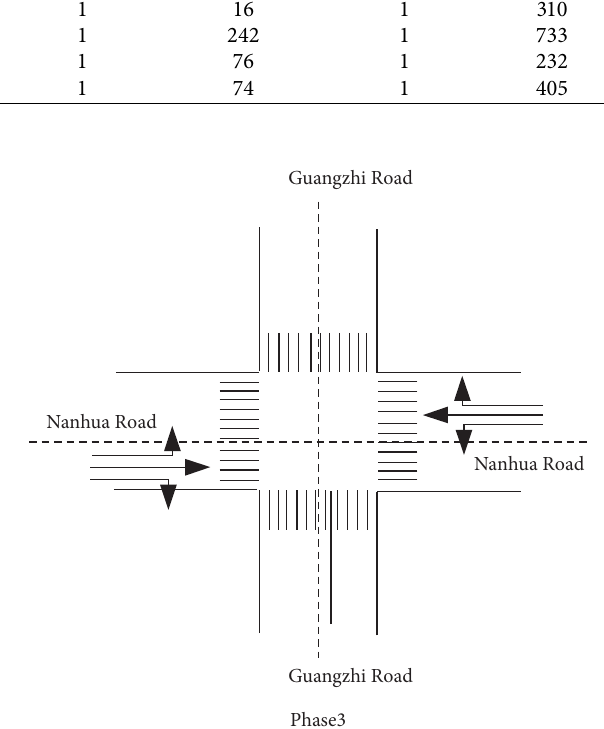
Figure 3: Timing design adopted for three-phase signal control.